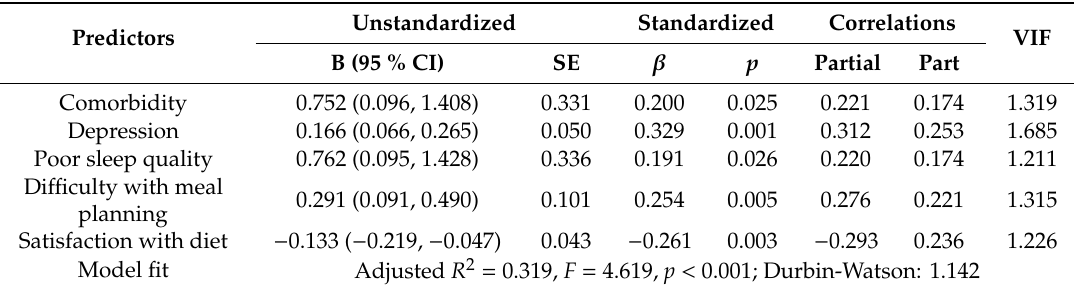
Table 3. Simultaneous multiple regression of selected predictors for fatigue severity after adjusting by biological, interpersonal, and contextual